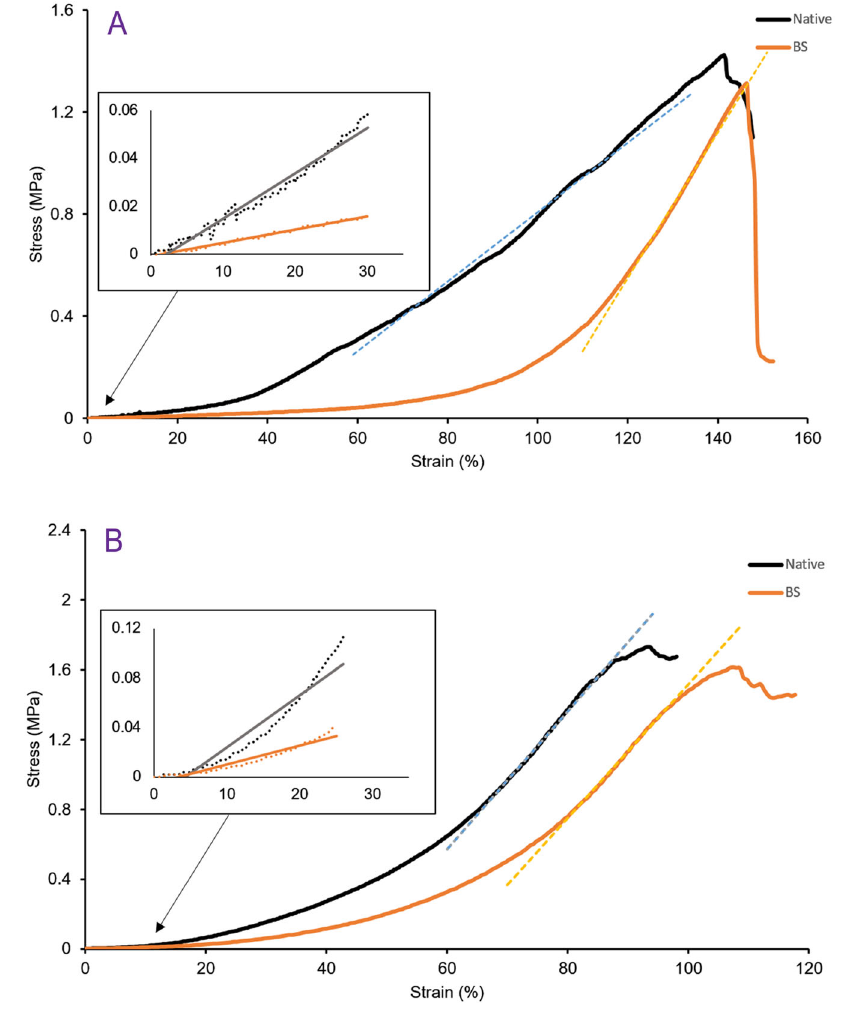
Fig. 5 Tensile test. Stress – strain curve of native blood vessel and BS in longitudinal ( A ) and radial ( B ) axis. Inlet graphs show stress – strain curve in the small strains with more details which belongs to elastin region. Linear part in high strains is collagen region